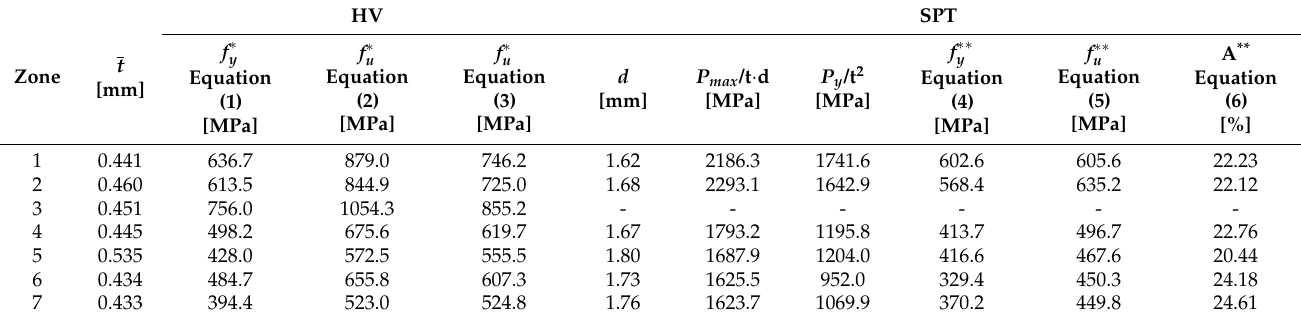
Table 11. Thickness, SPT results, and estimated properties through HV (*) and SPT (**) of the T10 M20 K800 specimen.